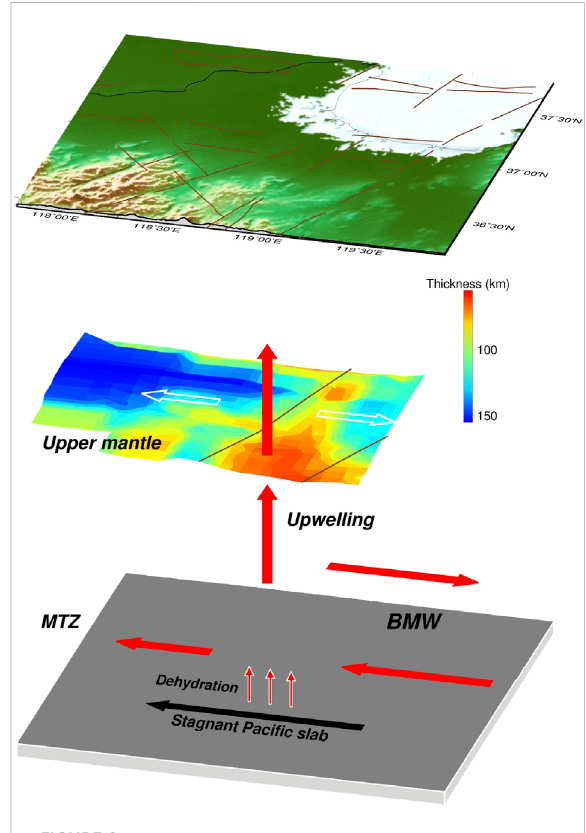
FIGURE 9 A schematic model showing the anisotropic structure and dynamics beneath the Tanlu fault zone. The black arrow indicates the moving direction of the Paci fi c slab in the mantle transition zone (MTZ). The white arrows represent horizontal material fl ow proposed by the fast direction of azimuthal anisotropy in the present study. The bold red arrows show the directions of horizontalandvertical fl owsinthebigmantlewedge(BMW)dueto the long stagnancy and deep dehydration (small red arrows) of the subducted Paci fi c slab in the MTZ. The colors in the middle panel denote the thickness of the mantle anisotropic layer determined byassuminganaverageanisotropyof4%.Thelayerthicknessscale is shown on the